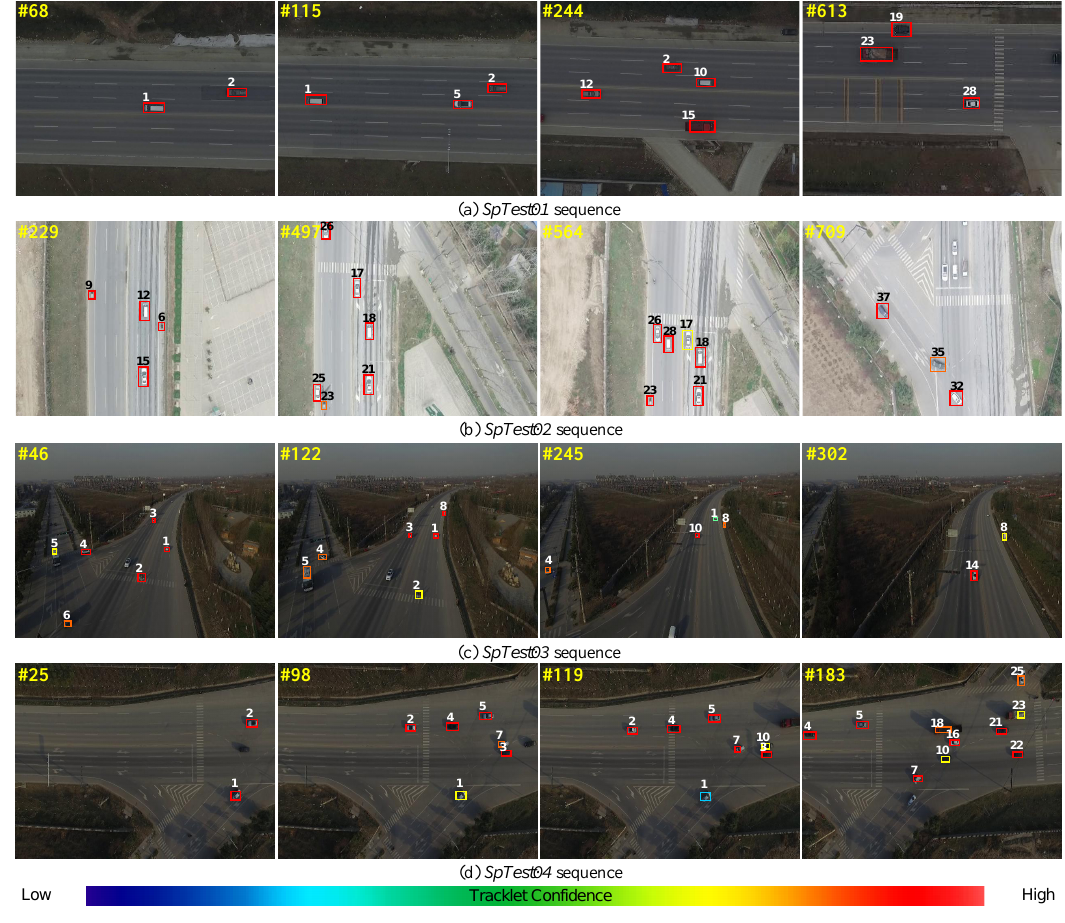
Figure 10. The results on four sequences from the SAIIP